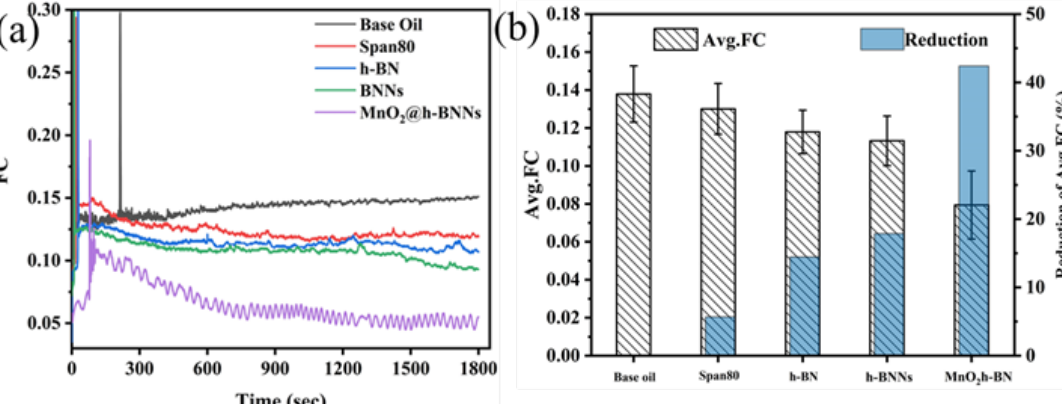
The antiwear performance of MnO 2 @h-BNNs nanoadditives blended with base oils